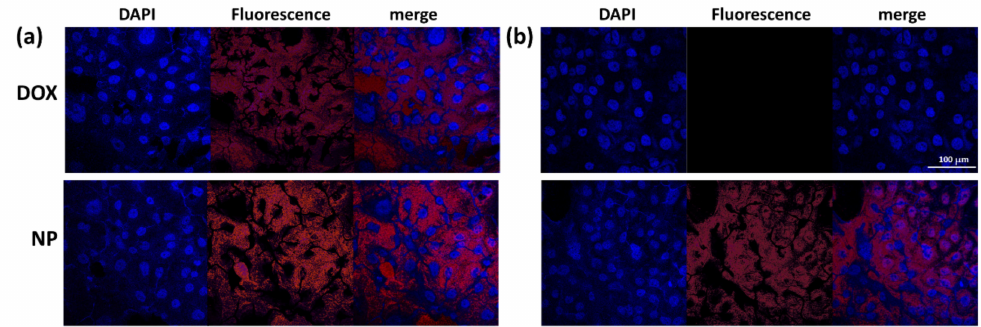
Figure 7. ( a ) The effect of DOX and DOX-incorporated ChitoHISss nanoparticles (NP) on the fluores- cence observation of HuCC-T1 cells ( a ) and DOX-resistant HuCC-T1 cells; ( b ) bar = 100 µ